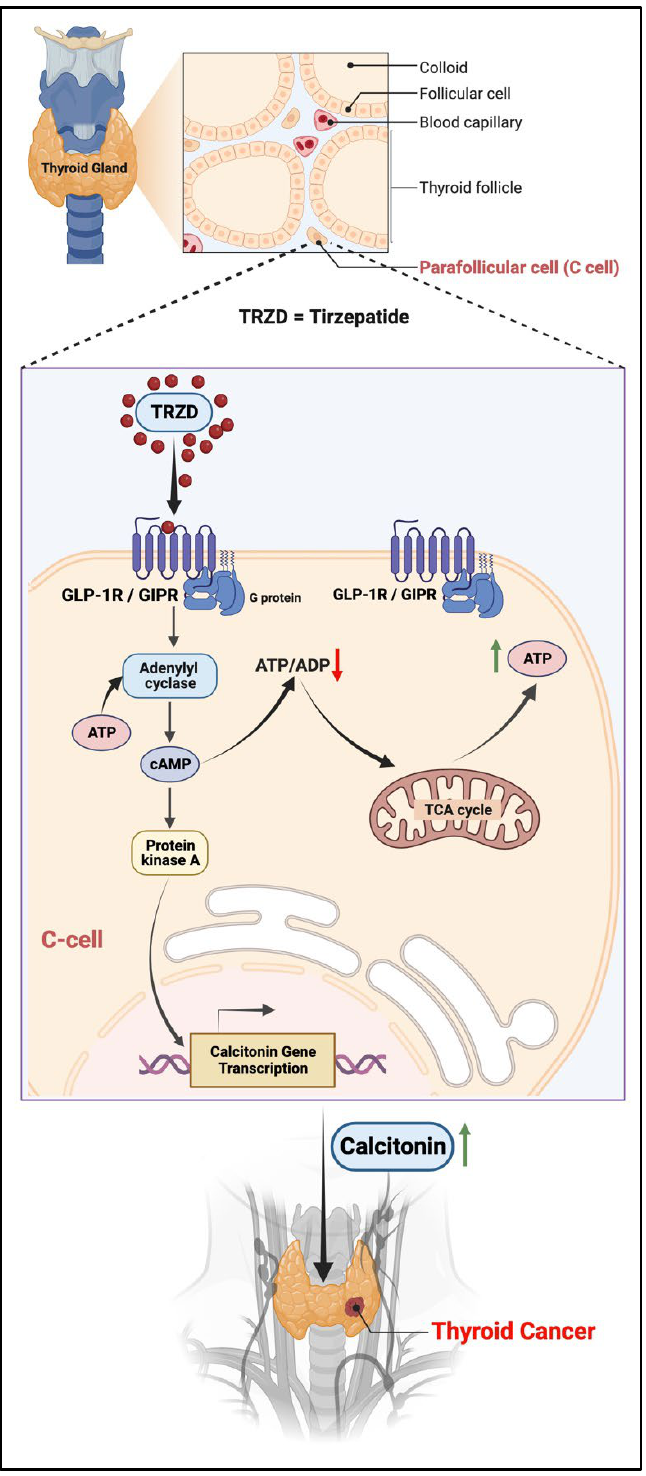
Figure 3. Possible pro-oncogenic effect of tirzepatide (TRZD) on the thyroid gland. TRZD via GLP-1R or GIPR activation leads to an increase in the intracellular levels of cAMP and protein kinase A activation, which drives the expression and secretion of calcitonin. The sustained activation of these receptors and release of calcitonin is accompanied by C-cell hyperplasia and transformation into C-cell adenomas and MTC. The black arrows indicate the pathway and flow of components involved in the pathway. The green upward arrow indicates an increase, while the red downward arrow indicates a decrease. Created with Biorender.com (accessed on 13 September 2022).